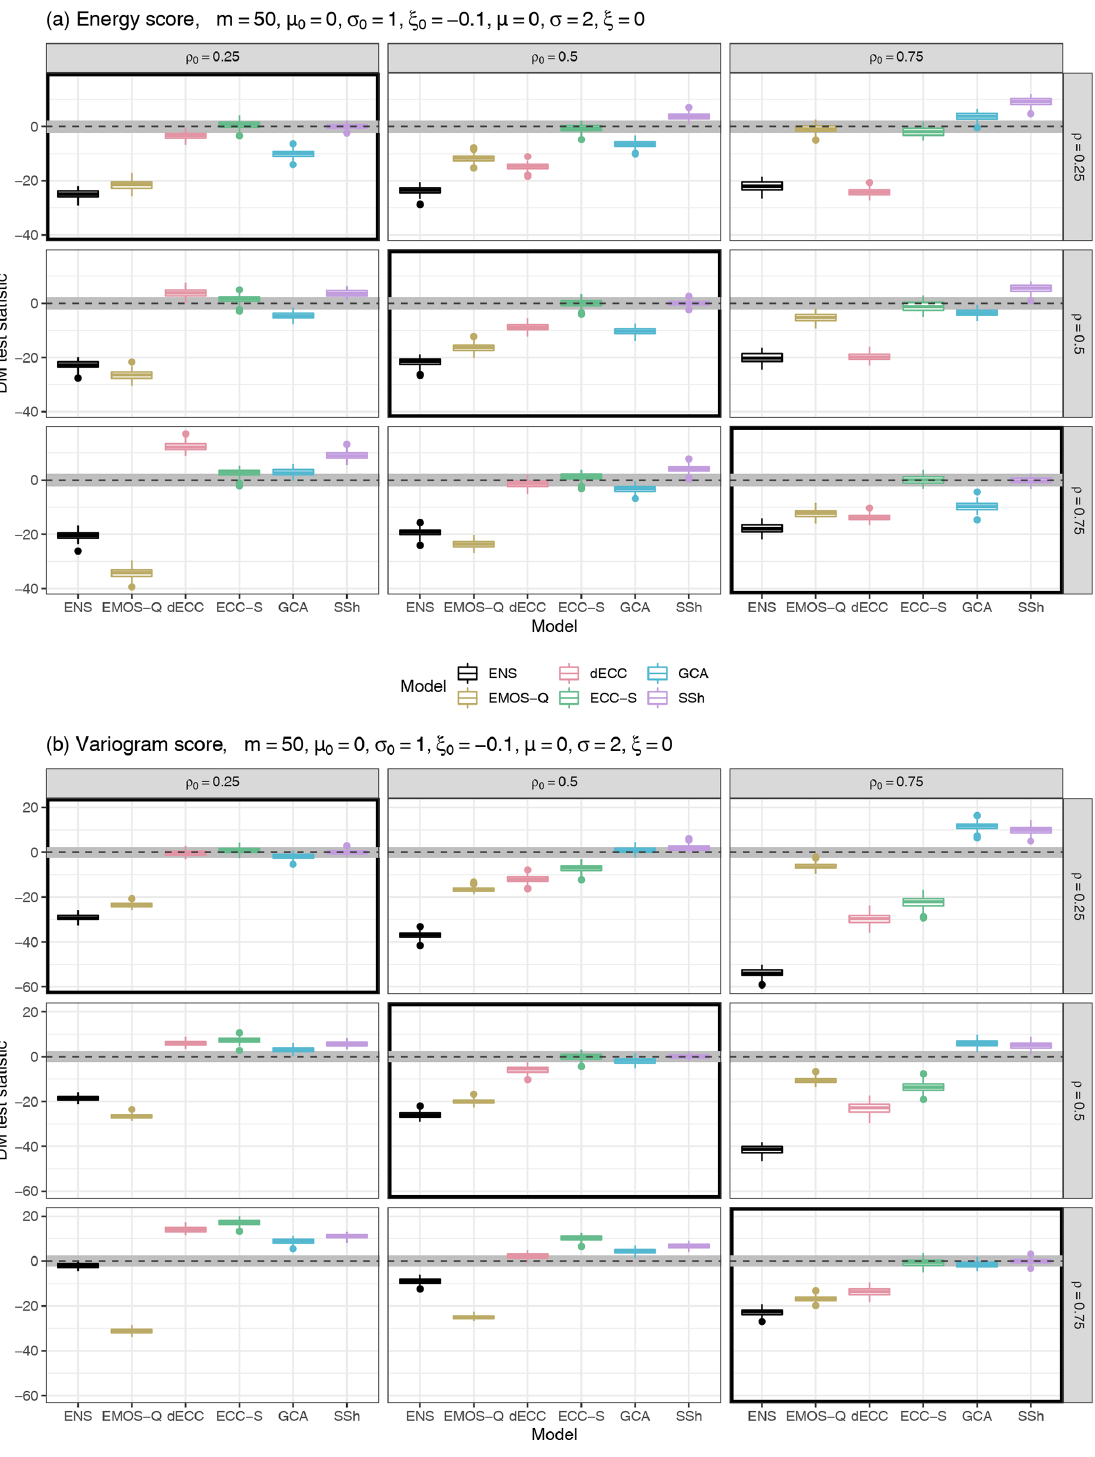
Figure 4. Summaries of DM test statistic values based on the ES (a) and the VS (b) for Setting 2, Scenario B from Table 2, based on m = 50 ensemble members. ECC-Q forecasts are used as a reference model such that positive values of the test statistic indicate improvements over ECC-Q and negative values indicate deterioration of forecast skill. Boxplots summarize results of the 100 Monte Carlo repetitions of each individual experiment. The horizontal gray stripe indicates the acceptance region of the two-sided DM test under the null hypothesis of equal predictive performance at a level of